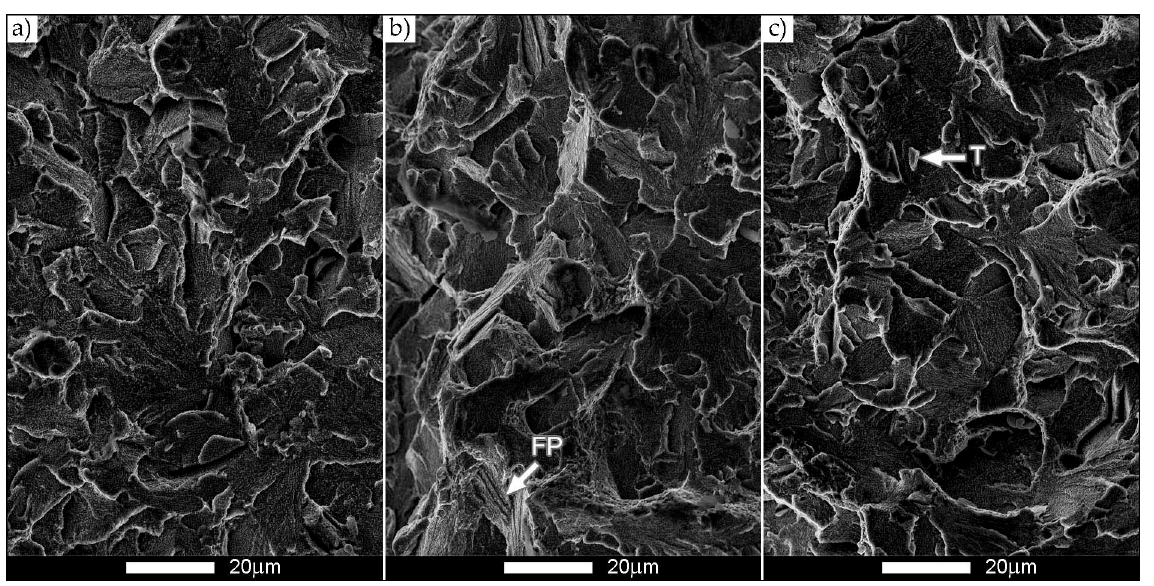
Figure 15. Images of the Hardox Extreme steel fracture surface in normalized state shown in Figure 10: longitudinal ori- entation (+20 °C). ( a ) The area marked with the A1 frame. ( b ) The area marked with the B1 frame. ( c ) The area marked with the C1 frame. DF—ductile fracture, PS—parallel steps, FP—fan pattern, T—tongues, IS—intergranular steps. SEM, non-etched state.